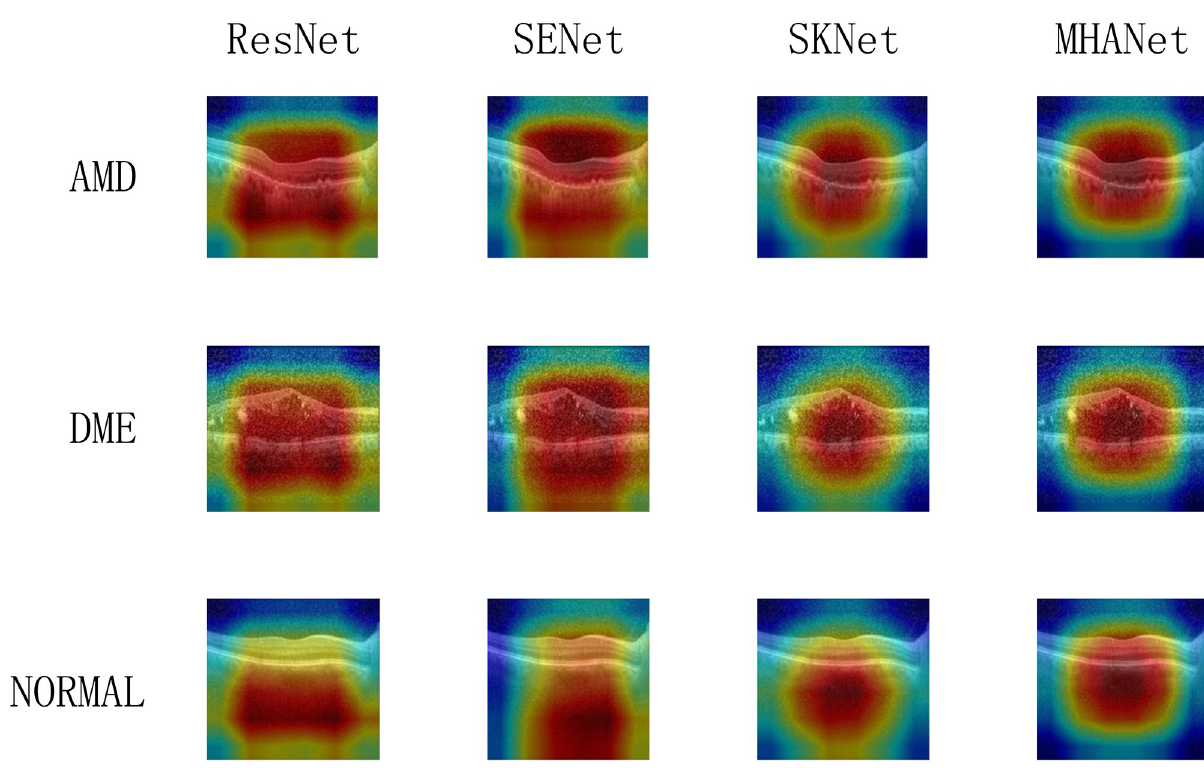
Fig 11. Heat map of